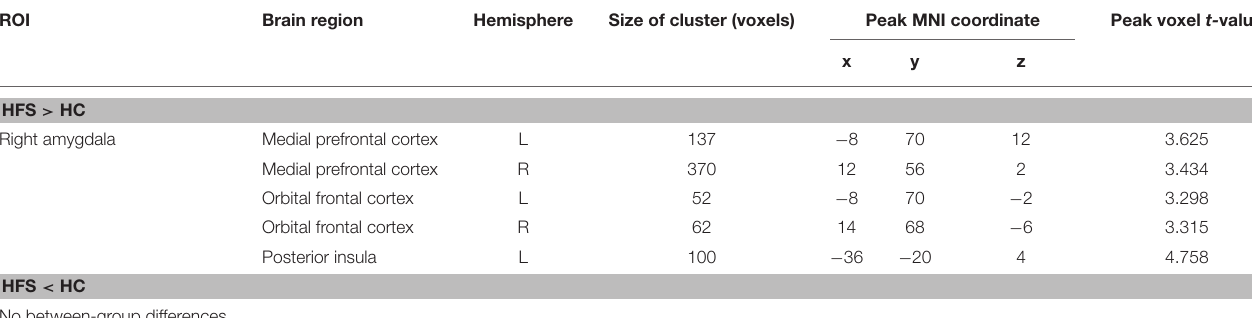
ROI, region of interest; MNI, Montreal Neurologic Institute; L, left; R, right.